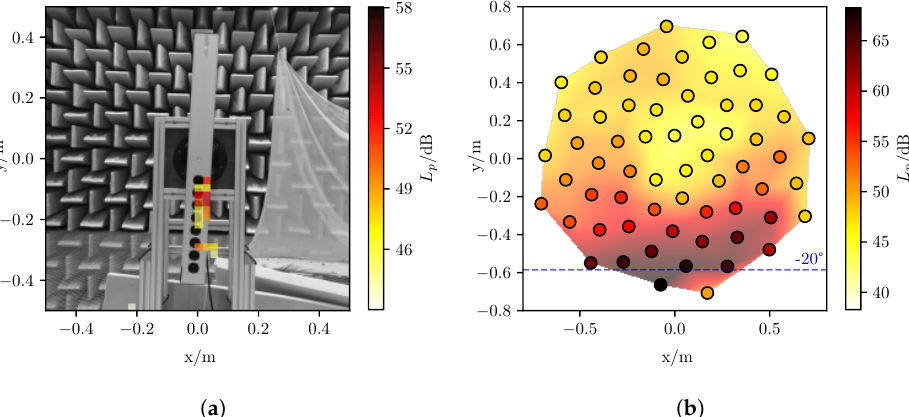
Figure 6. Test case 3 with a rotating speaker array and 20 ◦ negative direction steering: ( a ) source distribution; ( b )source directivity in the direction of the microphones at the 5 kHz octave band. The blue dotted line indicates the theoretical maximum at